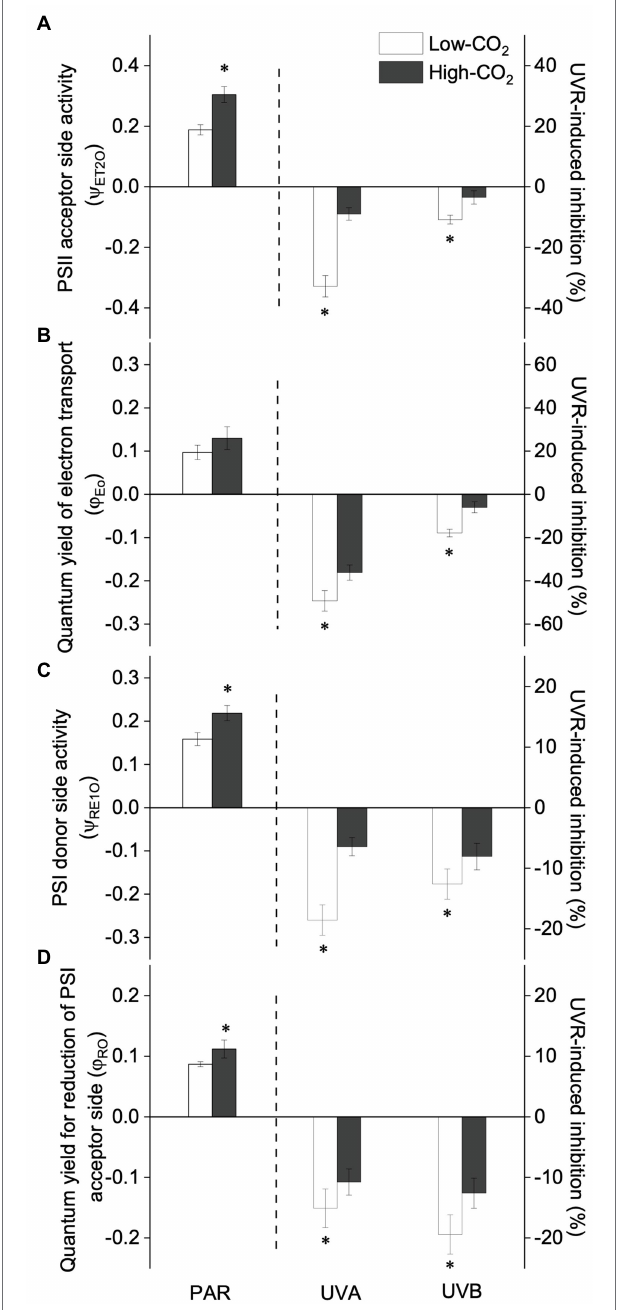
FIGURE 3 | Values (a.u., left pair of bars) and UVR-induced inhibition (%, right two pairs of bars) of PSII acceptor side activity [the probability that trapped excitons move electrons into the electron transport chain beyond Q A − , ET2O ψ , panel (A) ], quantum yield of electron transport [ φ Eo , panel (B) ], PSI donor side activity [the probability that an electron moves from reduced Q A beyond PSI, RE1O ψ , panel (C) ] and the quantum yield for reduction of PSI acceptor side [ φ Ro , panel (D) ] of P. yezoensis growing for 9 days at low (~400 μ atm, open bars) and high (~1000 μ atm, closed bars) CO 2 conditions. Data are means ± SD ( n = 3). The symbols “ * ” indicates a significant ( p < 0.05, t -tests) difference between the treatments in each pair.